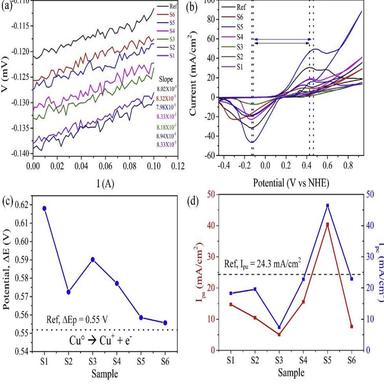
(a) V vs I plot (four-probe measurements), the values of the slope (U/cm2 ) represent the resistivity and are given in the inset. (b) Cyclic voltammetry measurements in the range of 0.7 Ve0.7 V with a scan rate of 20 mV/s. (c) Oxidation potential and (d) anodic and cathodic currents of S1 to S6. (A colour version of this figure can be viewed online.)